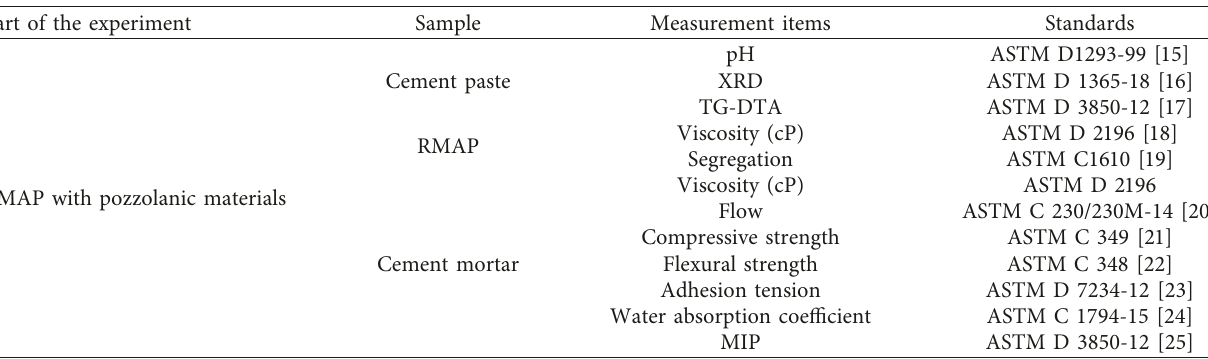
Table 8: Measurement methods for different parts of the